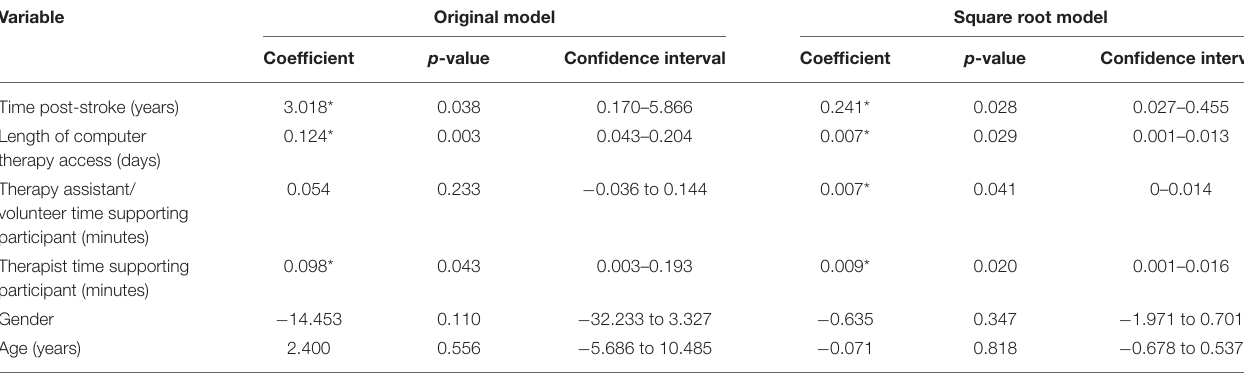
TABLE 3 | Regression coefficients and p -values for the original and square root multiple linear regression